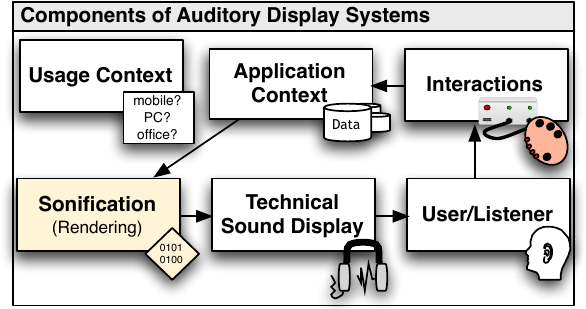
Figure 2: Auditory Displays: systems that employ sonifica- tion for structuring sound and furthermore include the trans- mission chain leading to audible perceptions and the appli- cation